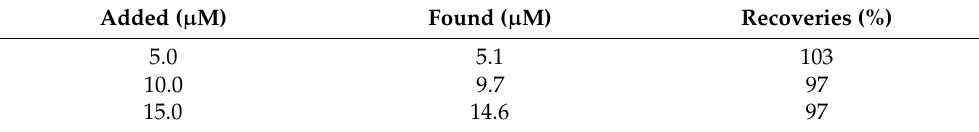
Table 2. Practical analysis of SCZ in the blood serum sample at ZTO/TO MPs/GCE. Added (µM) Found (µM)